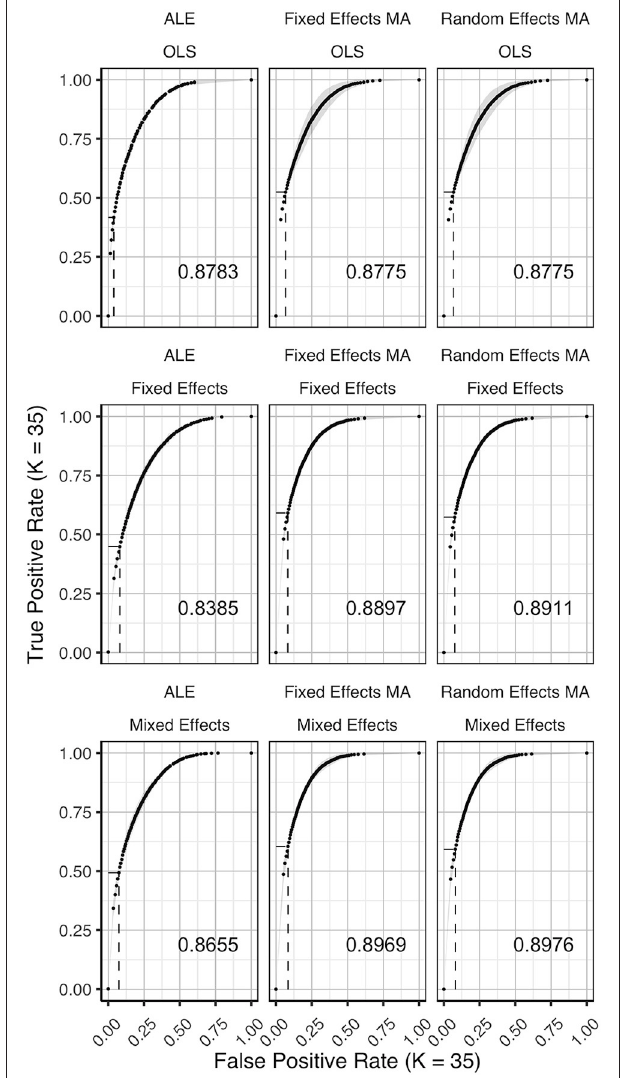
FIGURE 5 | ROC curves ( 1 standard deviation), averaged over I 2 folds ± = plotting the observed true positive rate against the observed false positive rate for K 35. The columns correspond to the coordinate-based meta-analyses = (left, ALE uncorrected procedure; middle, fixed effects meta-analysis; right, random effects meta-analysis). The rows correspond to the second level GLM pooling models ( top , OLS; middle , fixed effects; bottom , mixed effects). For each of those, the area under the curve (AUC) is calculated and shown within the plot. The drop-down lines correspond to the point at which the pre-specified nominal level is set at an uncorrected α level of 0.05.